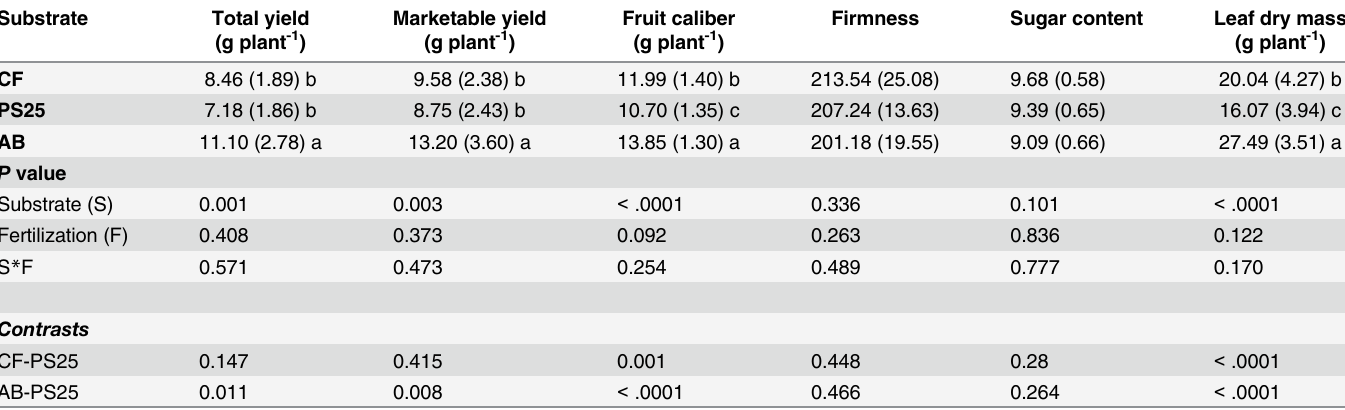
Table 5. Effect of substrate type on average total yield, marketable yield, fruit quality parameters and final leaf dry mass. (Fall 2012, 18 harvests: from March 23th, 2012 to May 2 nd , 2012). Two fertilizer rates were tested, with the second fertilizer rate (F2) at concentration twice that of F1. Different letters indicate significant differences at P =